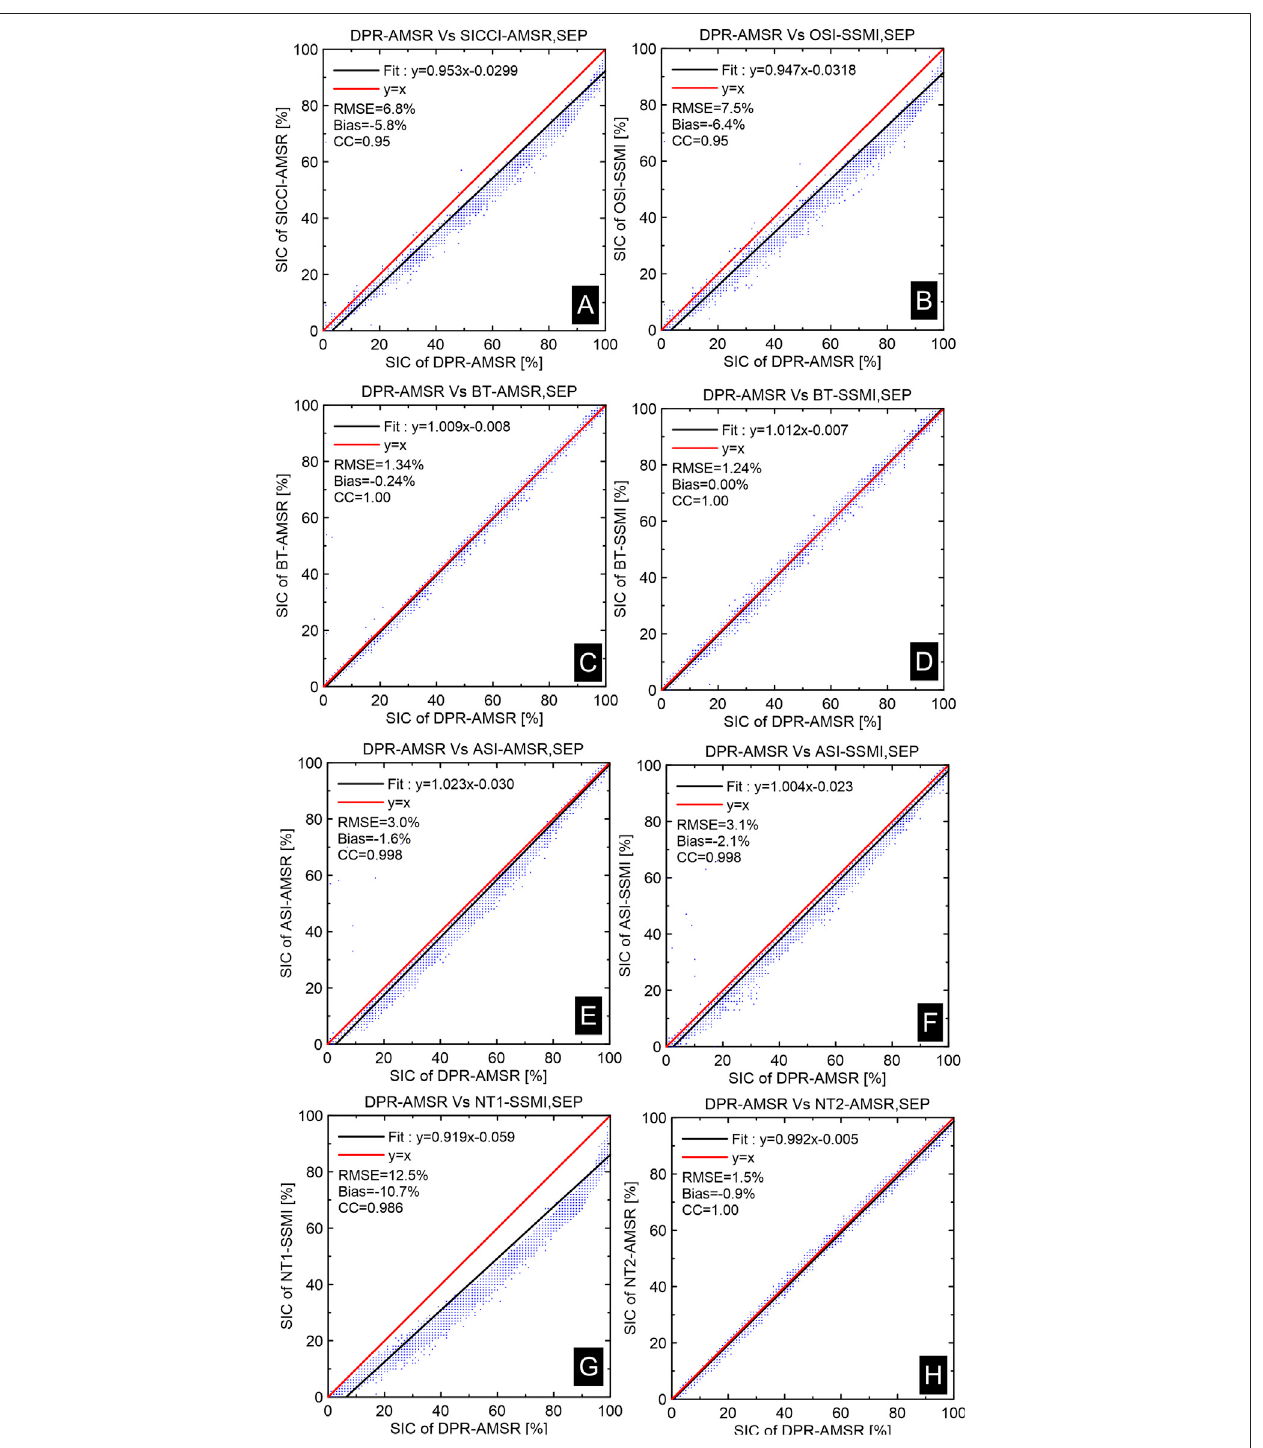
FIGURE 6 | Scatterplots of ensemble mean multi-annual average monthly sea ice concentration of DPR-AMSR and other eight sea ice concentration data sets in September (2002 – 2015): SICCI-AMSR (A) , OSI-SSMI (B) , BT-AMSR (C) , BT-SSMI (D) , ASI-AMSR (E) , ASI-SSMI (F) , NT1-SSMI (G) , and NT2-AMSR (H) . Red solid lines represent the equality y = x . Black solid lines represent linear fifi ts of data points. Linear equations, correlation coef fifi cients (CC), and biases and root mean square errors (RMSE) are also presented.